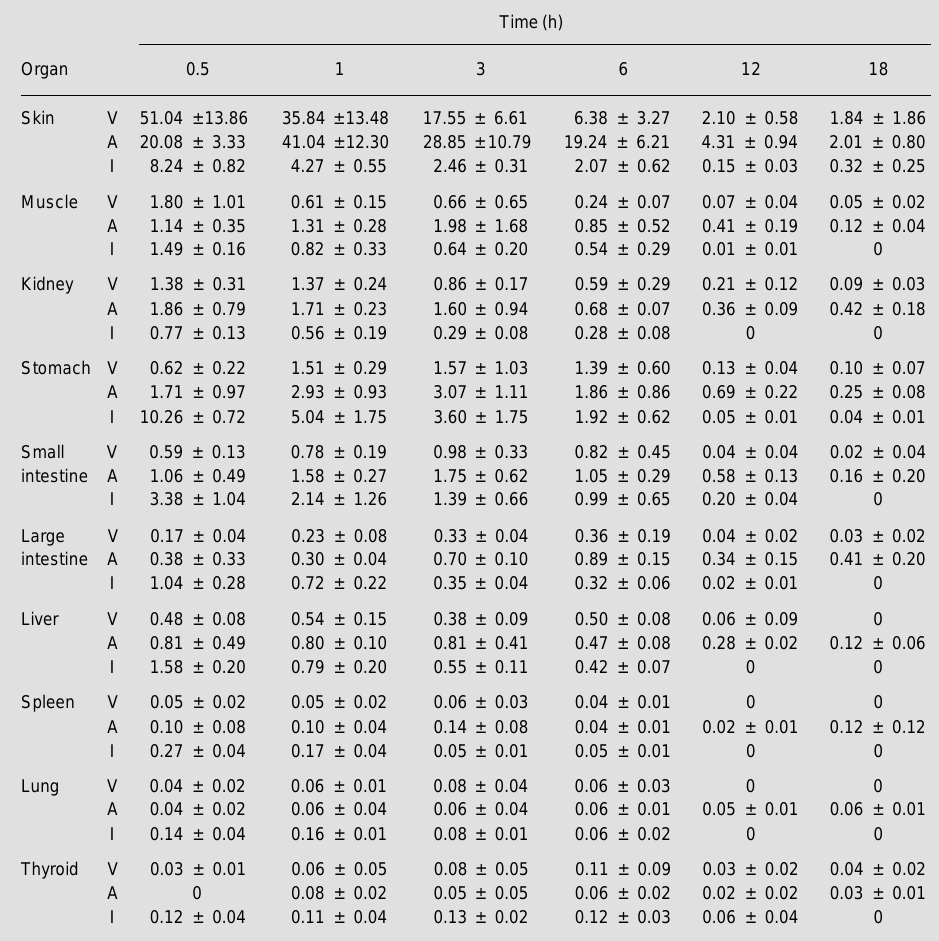
Table 1 - Distribution of 131 I-labeled Bothrops erythromelas venom (V), 131 I-labeled albumin (A) and 131 I (I) in mice. Radioactivity is reported as percentage of the total dose administered (235,000 cpm). Data are reported as the mean ± SD for 3 experiments. No radioactivity was detected in the brain, heart, diaphragm or